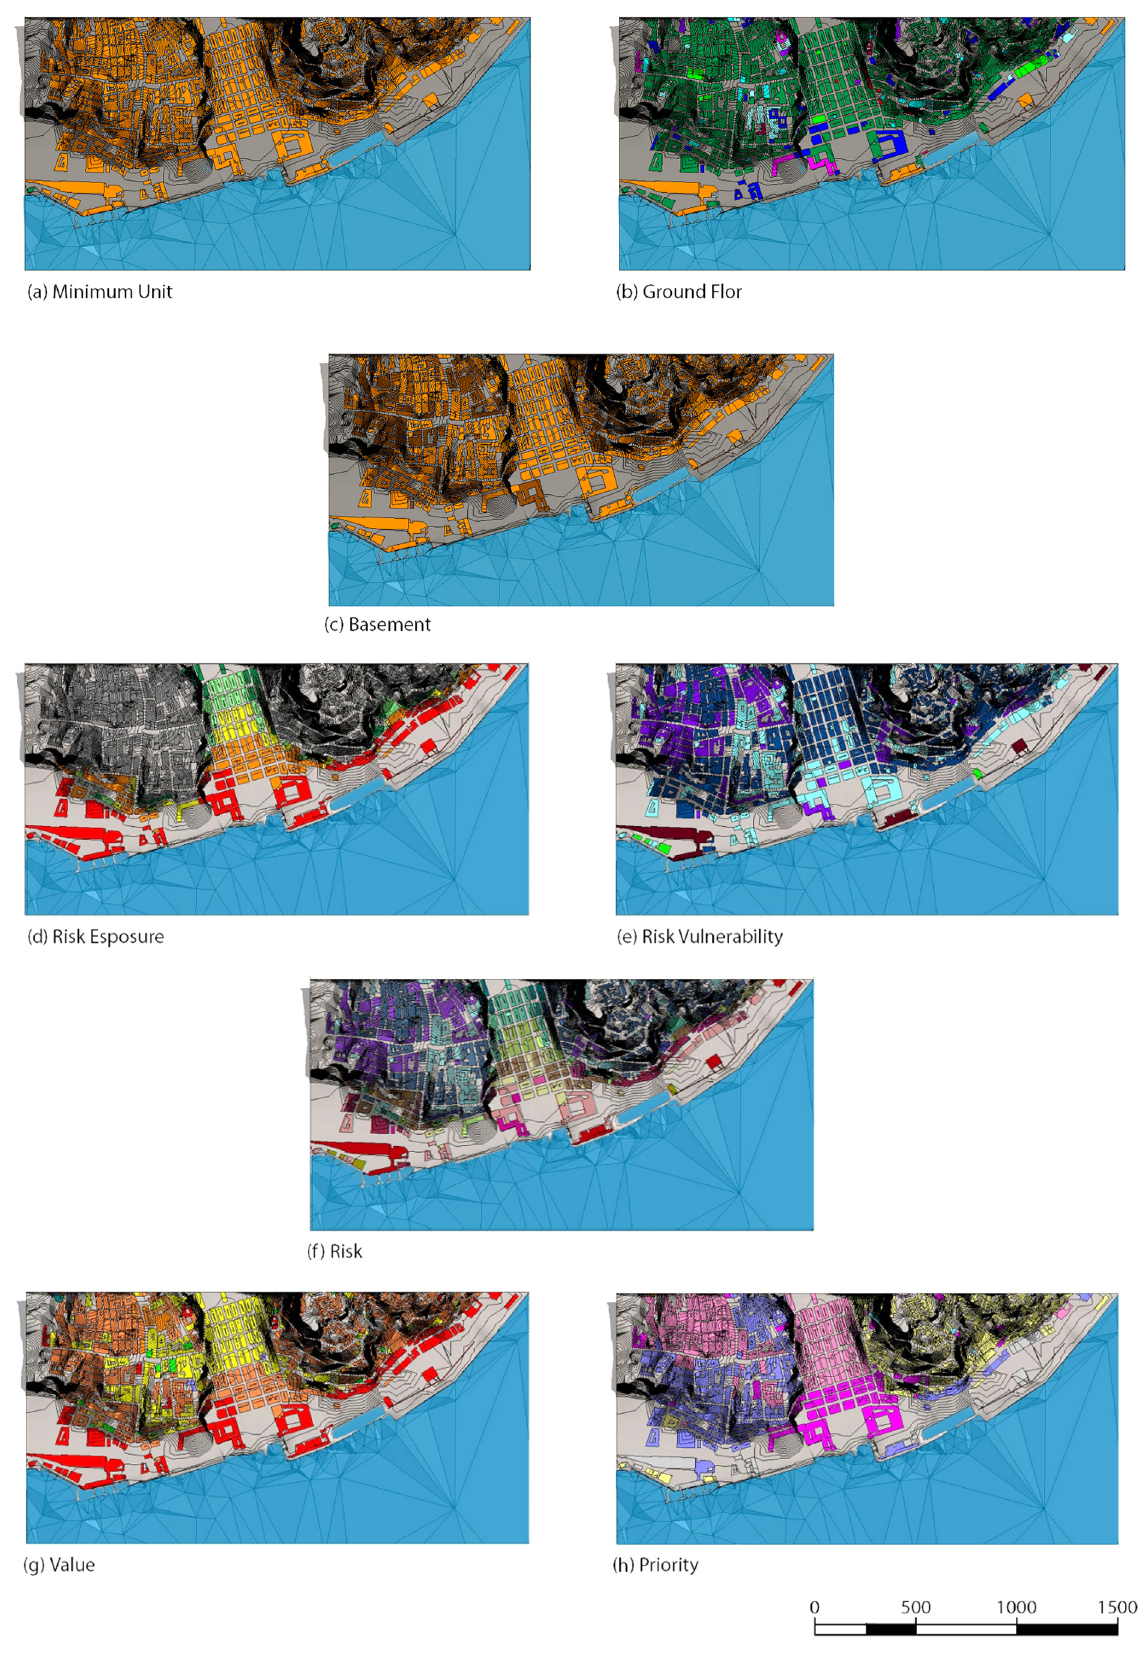
Figure 11. All the maps produced for this case